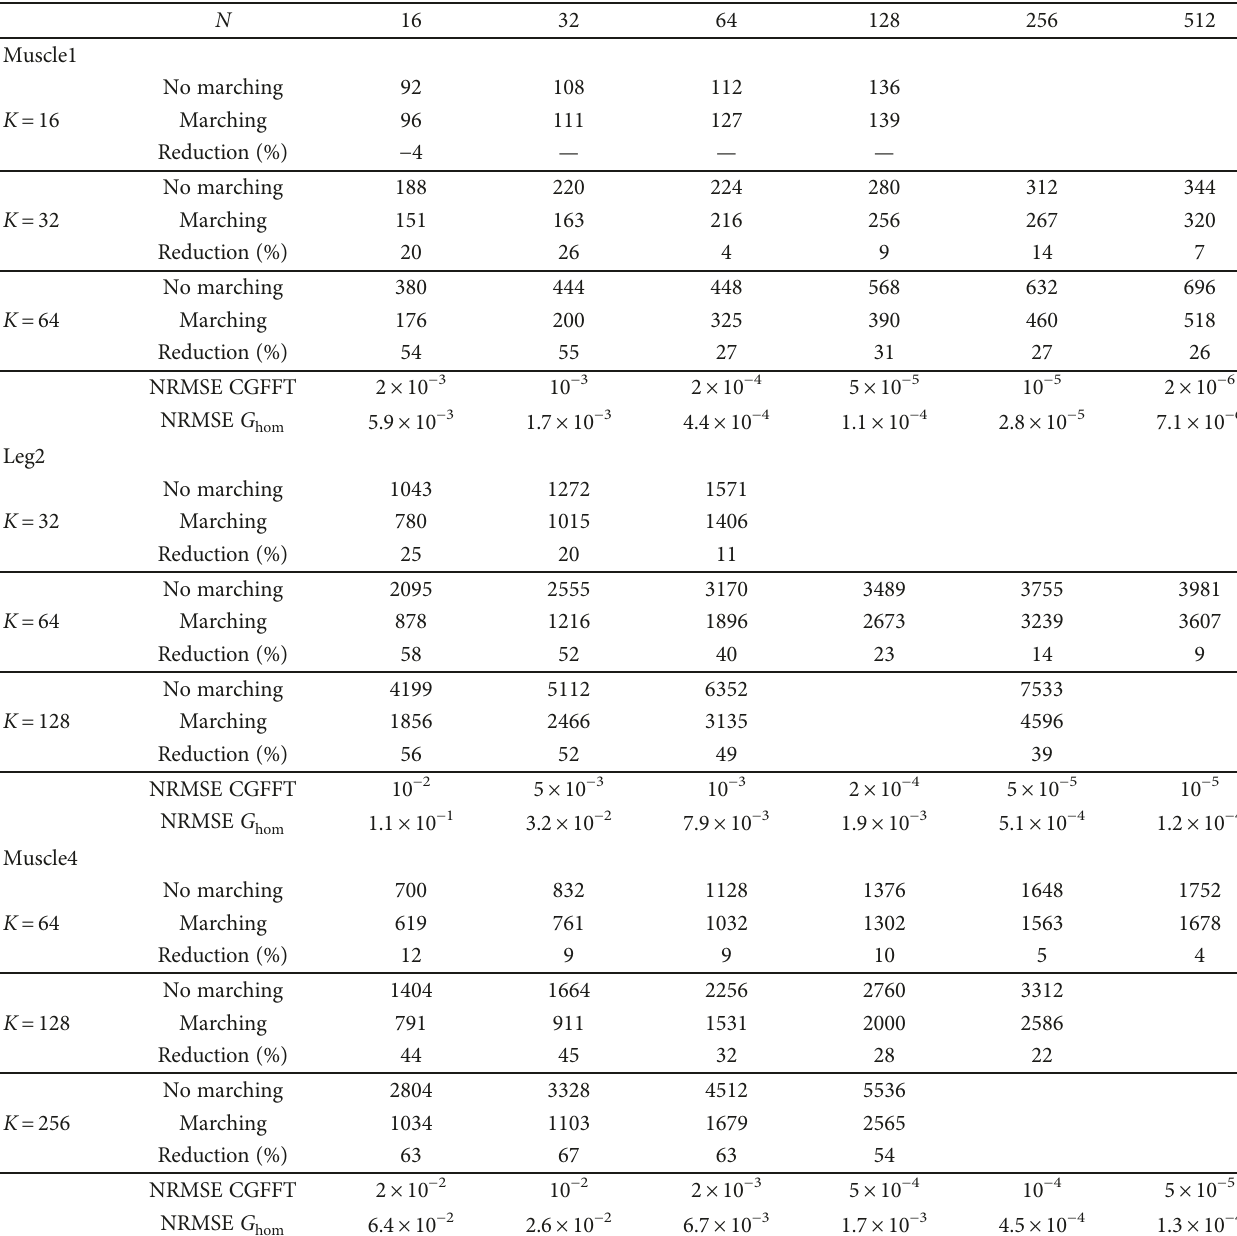
Table 2: Comparison of the total number of CGFFT iterations as a function of N and K for the conventional (i.e., incident fi eld initial guess) and “ marching on in angle ” approaches. The relative reduction in the number of iterations, the CGFFT stop criterium (NMRS CGFFT), and the resulting NRMSE for G on the grid also are hom